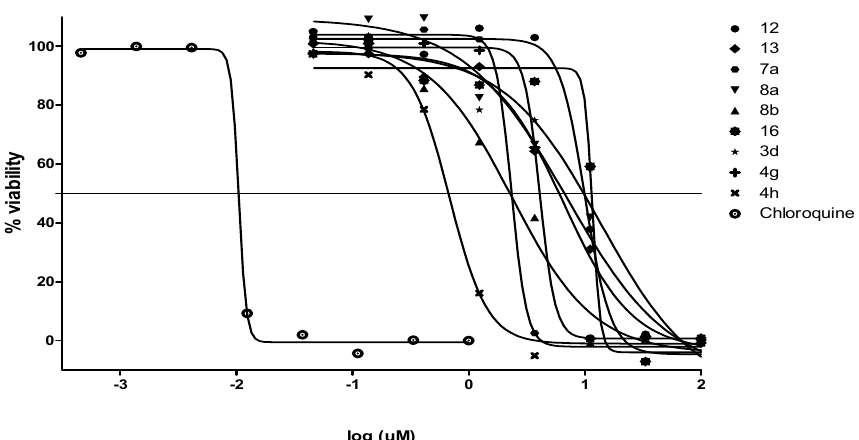
Figure 2. Dose-response curves of compounds active against P. falciparum compared with chloroquine.